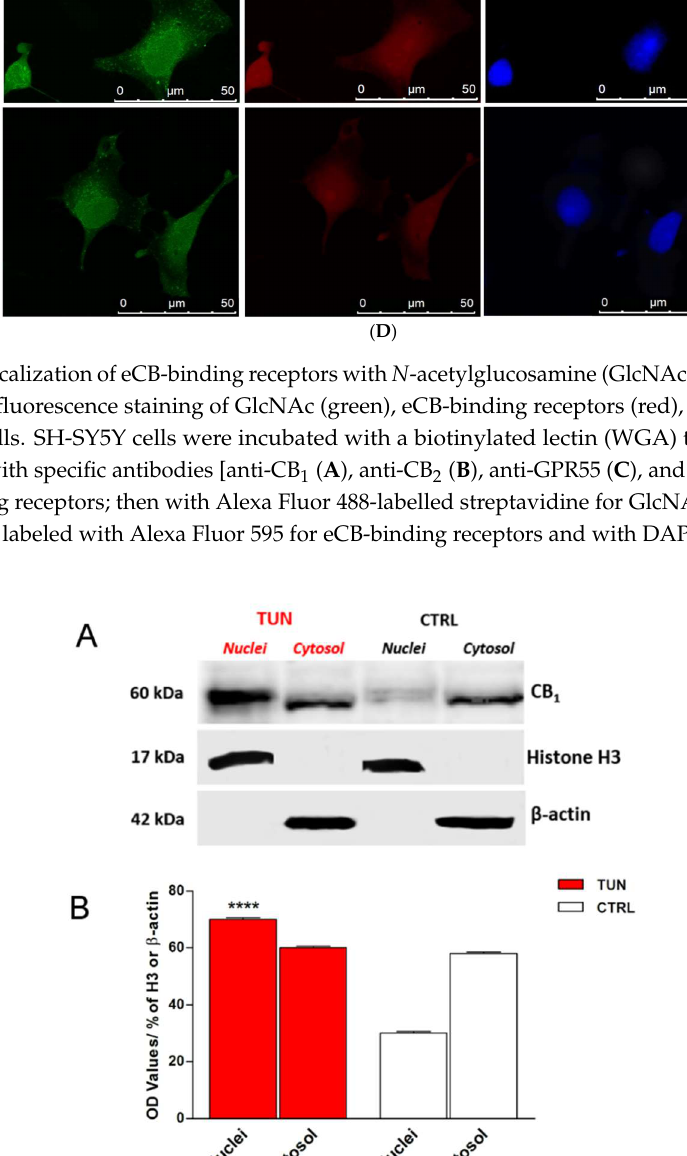
Figure 4. CB 1 immunostaining in the nuclear and cytoplasmatic fractions of SH-SY5Y cells, treated or not for 24 h with tunicamycin (TUN 1 µg/mL). Histone H3 and β-actin were used as loading controls for nuclear and cytoplasmatic fractions ( A ). Densitometric analysis of CB 1 immunoreactive band normalized to histone H3 and β-actin. Data are presented as means ± SEM (n = 3) [**** p < 0.0001 vs. nuclei CTRL] ( B ).